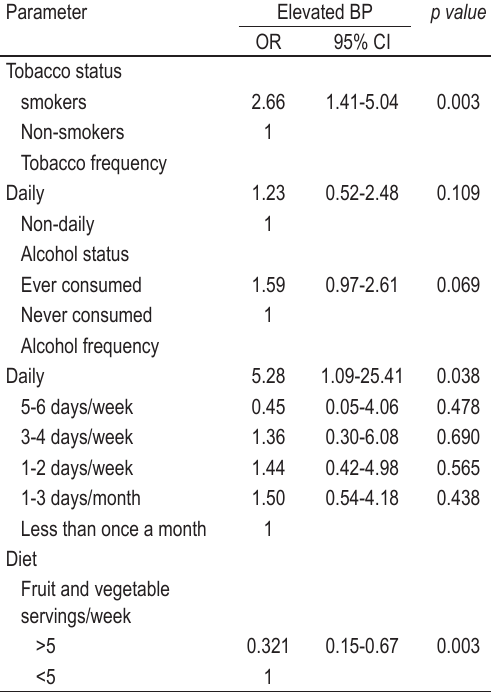
TABLE 5. Odds of HPT (SBP ≥140; DBP ≥90) according to the behavioral